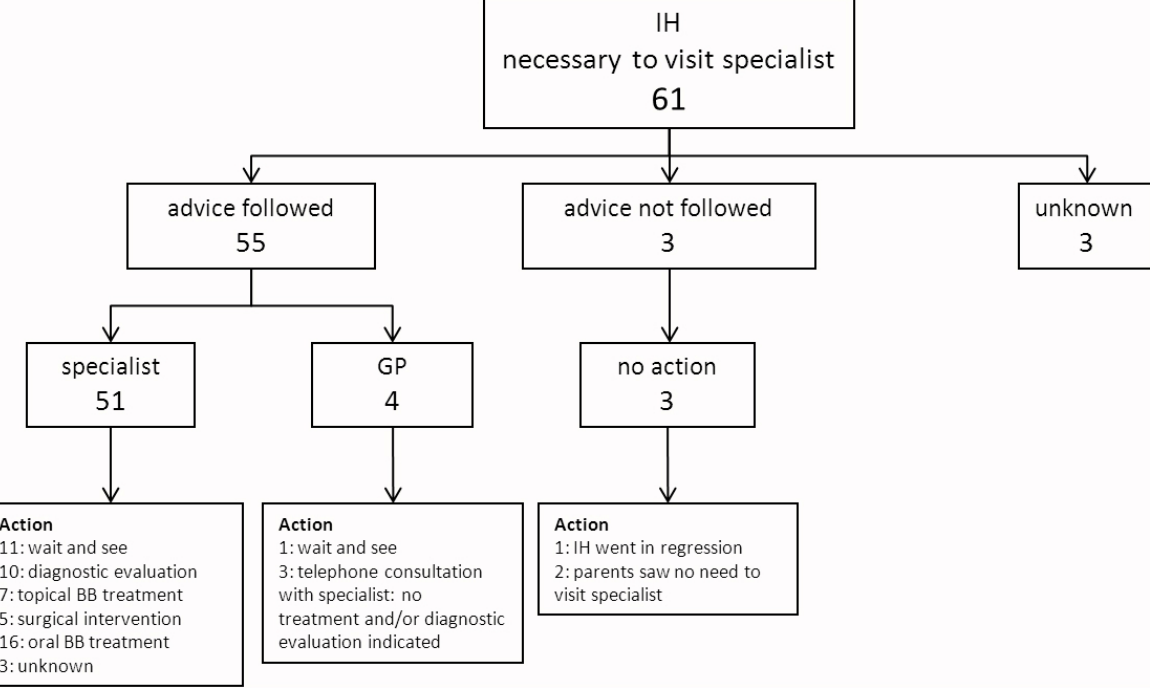
Figure 3. Flowchart of the compliance of the parents who were advised to visit a medical specialist by the dermatologist via e-consultation. The flowchart shows which doctor the parents visited and to what actions (eg, diagnostic evaluation and/or treatment) it has led. The figures indicate the number of patients. One patient, who followed the advice of the dermatologist and went to a specialist, underwent both diagnostic evaluation and topical beta blocker treatment was initiated. Infantile hemangioma(s) (IH); general practitioner (GP); and beta blocker